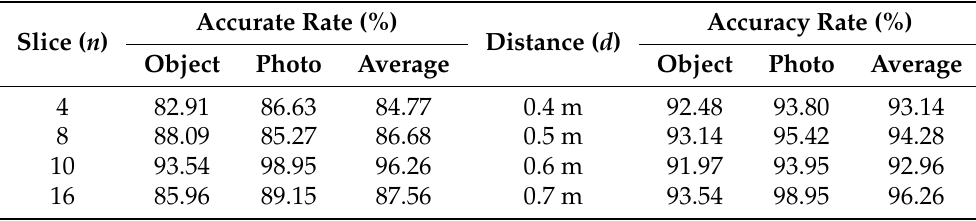
Table 1. The accuracy rate of different slice numbers (the distance d is equal to 0.7 m) and different distances (the slice number n is equal to